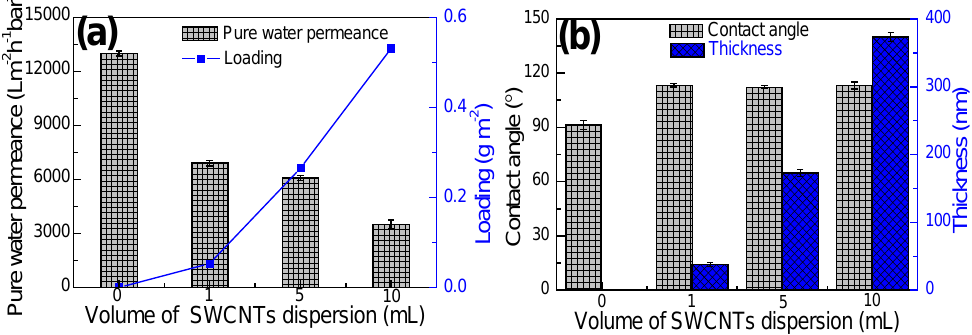
Figure 2. ( a ) Pure water permeance and ( b ) contact angle and thickness of MCE / CNTs support layer with volume of SWCNTs dispersion solution.